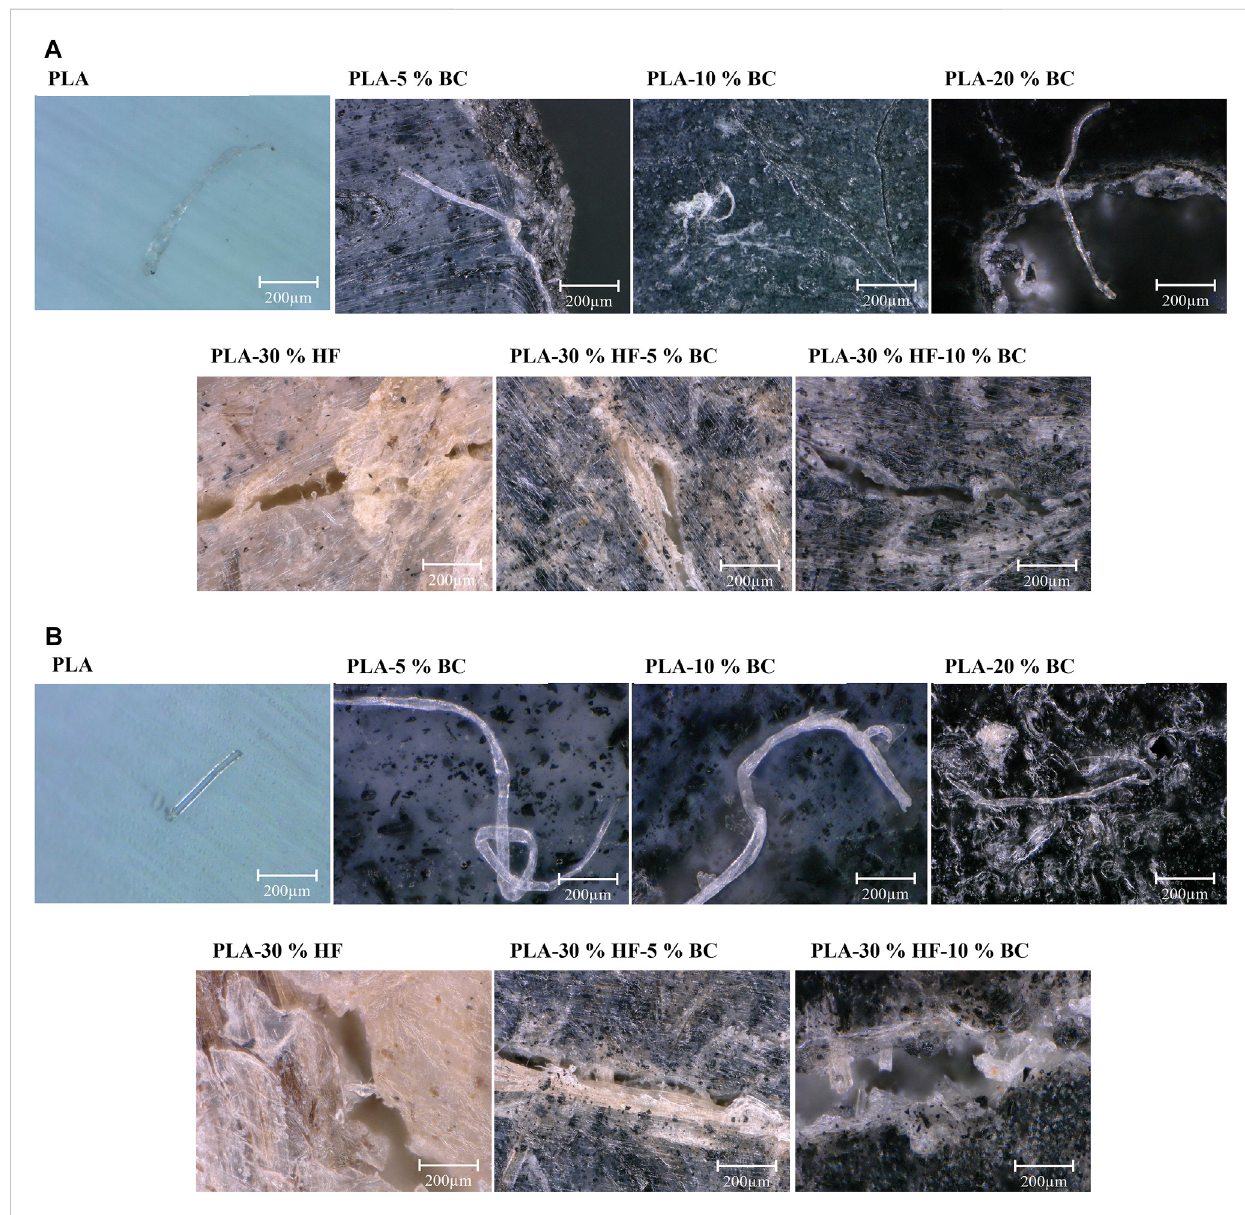
FIGURE 3 Microscopic images of the surface of specimens incubated with (A) white rot and (B) brown rot for 5